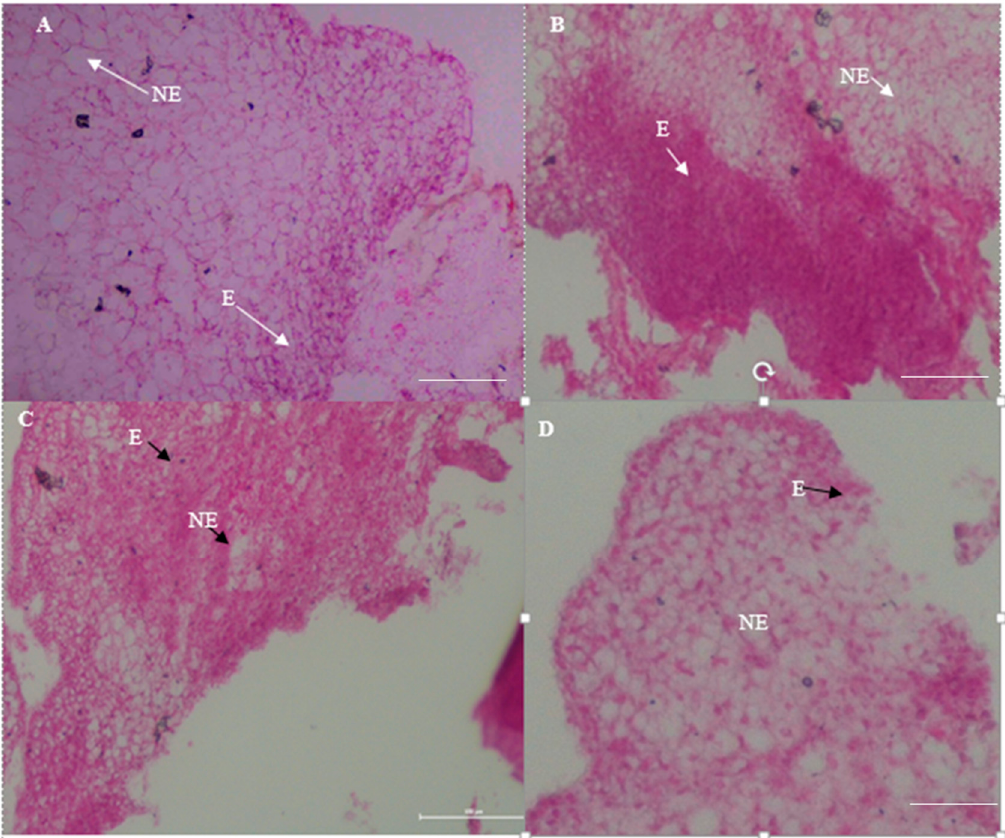
Figure 7. ( A – D ) Histological analysis of calli derived from in vitro tissue cultures on MS media containing 3 mg/L 2,4-D on MS media for ( A ) MR220; ( B ) MR220-CL2; ( C ) MR232, and ( D ) Bario. Calli inner region containing both small meristematic cells with stained nucleus in the mitotic cell zone indicate embryogenic callus ( E ) and vacuolated large cells indicate non-embryogenic callus (NE). Magnification 4 × 10, Bar = 100 µm.